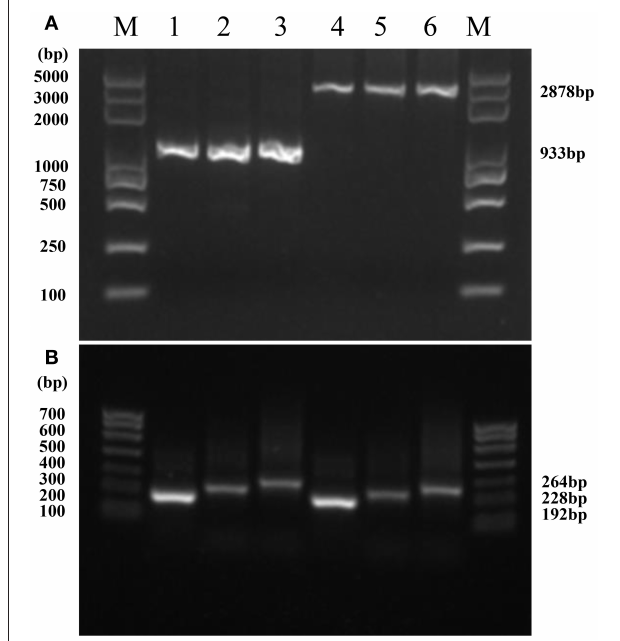
FIGURE 2 | Amplicon profiles of P. infestans mitochondrial regions: (A) Band patterns of the mitochondrial region I (HVRI) amplified by the primers Insertion-F and Insertion-R. Lanes 1–3 represent mtDNA type I and lanes 4–6 represent mtDNA type II; M lanes are MD5000 DNA marker; (B) : Band patterns of the mitochondrial region II (HVRII) amplified by the primers VNTR-F and VNTR-R. Lanes 1 and 4 represent R1; lanes 2 and 3 represent R2; and lanes 5 and 6 represent R3. M lanes are MD700 DNA